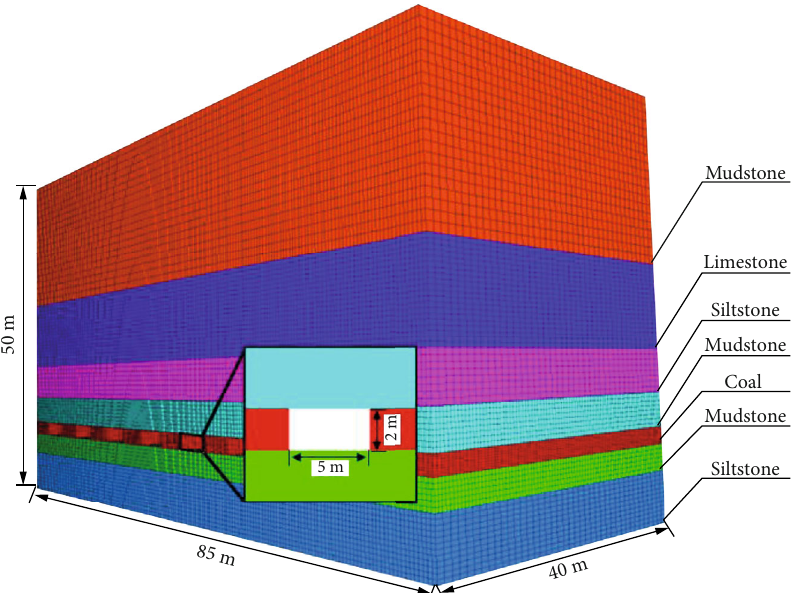
Figure 3: Calculation model of numerical